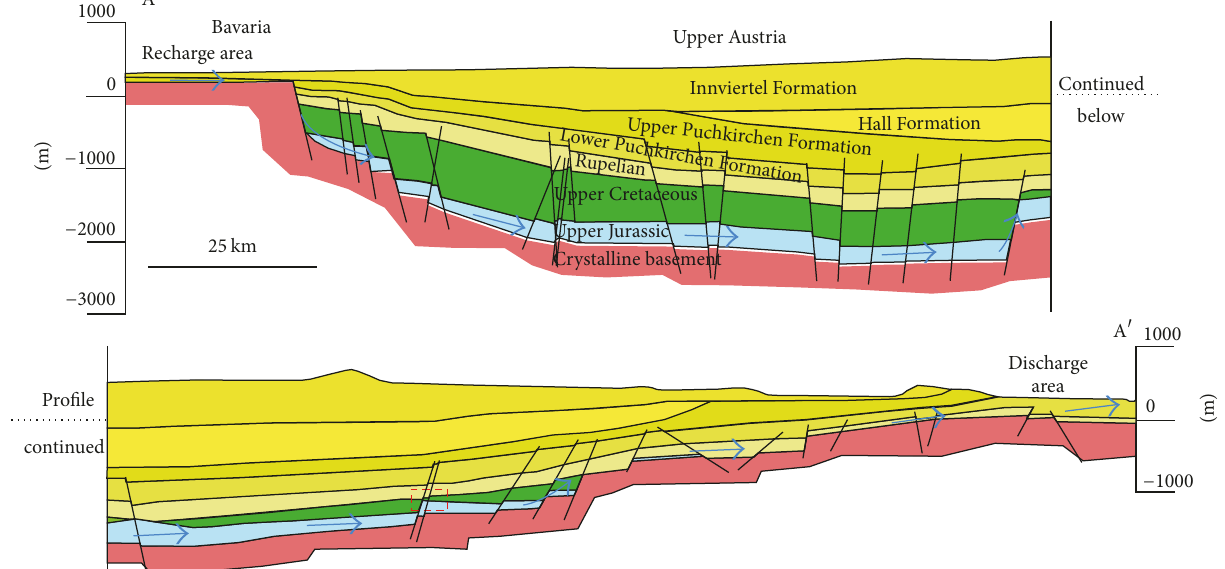
Figure 4: Regional cross section from the recharge area in Lower Bavaria to the discharge area west of Linz (Upper Austria) (modified from [6]). Position of cross section is indicated in Figure 3 by a dashed line. Area marked by red rectangle is displayed in Figure